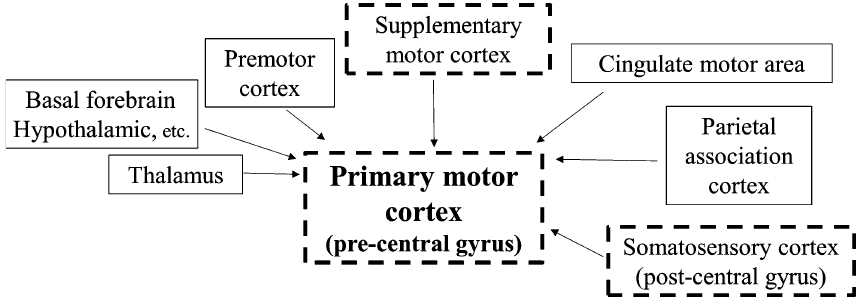
Figure 3. Input to the primary motor cortex. The primary motor cortex receives inputs from higher centers such as the premotor cortex and supplementary motor cortex, the somatosensory cortex, the parietal association cortex, and subcortical organization such as the thalamus and the basal forebrain. The dotted squares show that whose volume were significantly decreased in the CBS